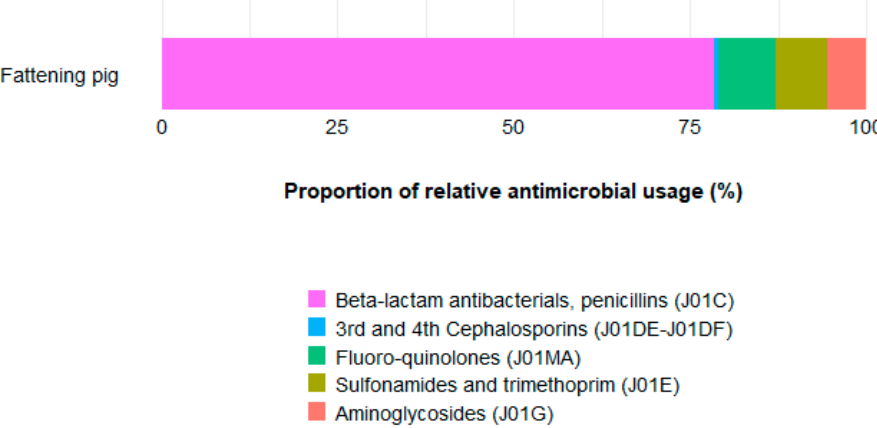
Figure 2. Proportion of relative use in humans, weaning and fattening pigs. The proportion of relative use in humans differed substantially from those in ani- mals. The relative use of penicillins (ATC code J01C) applied was lower in humans than in pigs. The contrary was observed for third and fourth generation cephalosporins (J01DE-